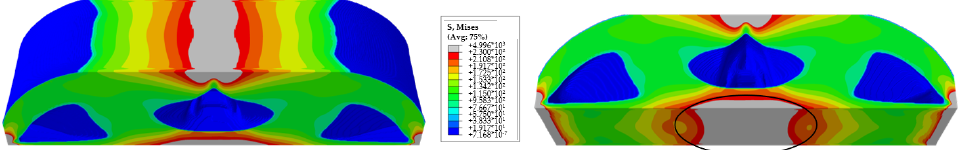
Figure 19. Results of the static FE analysis for the derived design proposal of the standard topology optimization under the boundary conditions of optimization case 1.